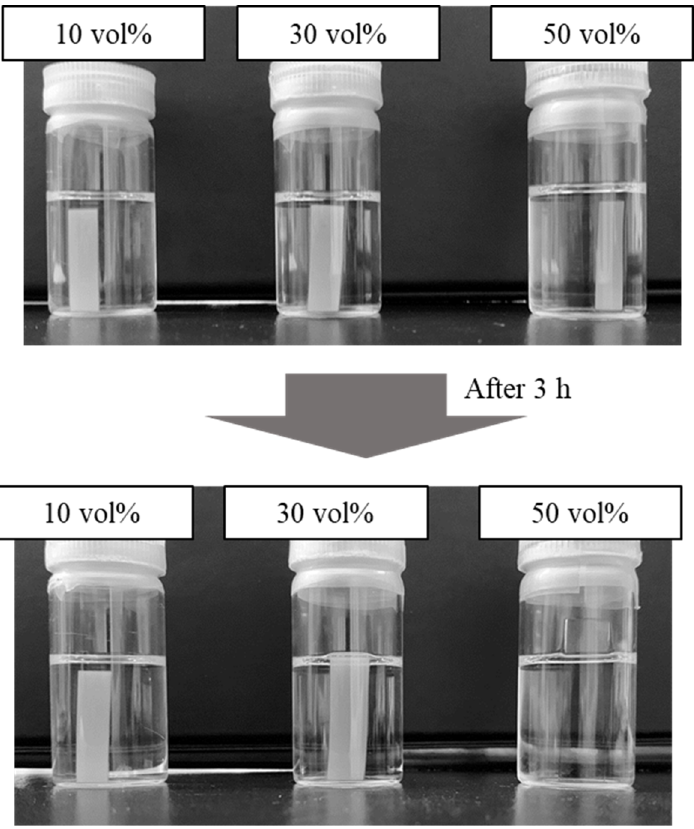
Figure 5. Photos of shape memory materials in reaction solution containing DMEDA with varied concentrations. The percentage indicated DMAEA concentrations.